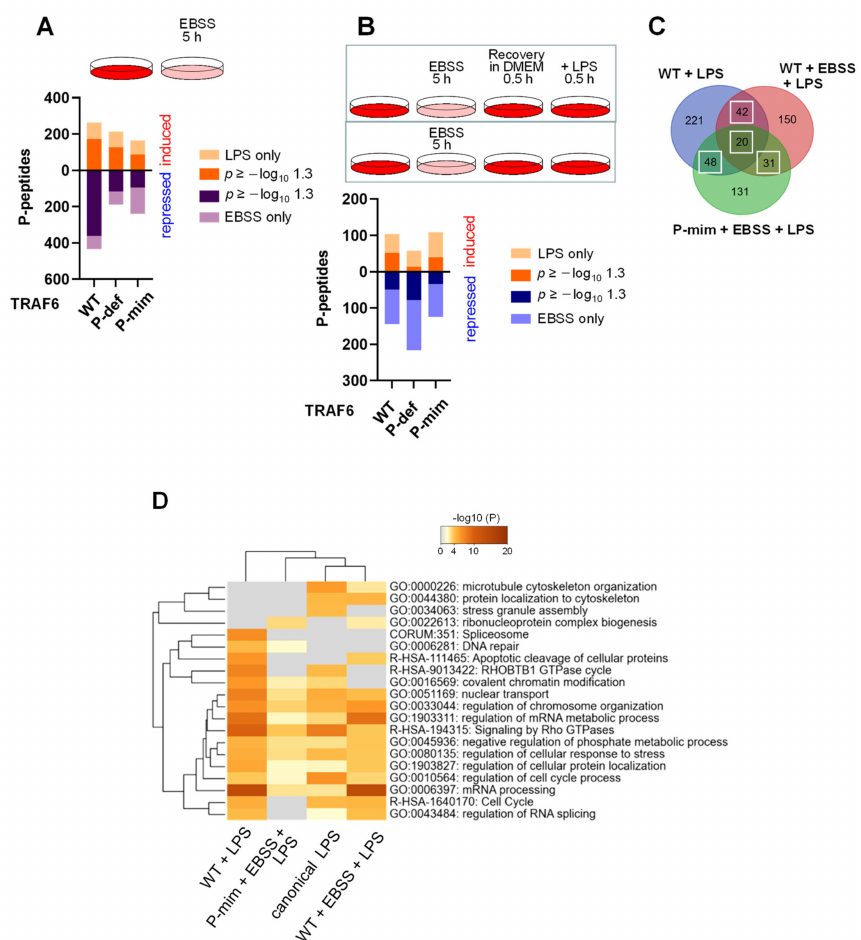
Figure 8. The impact of autophagy and TRAF6 phosphorylation on LPS-triggered phosphorylation networks. ( A ) The top shows the experimental design, the lower part shows the number of phosphopeptides that were increased or decreased after EBSS treatment in the cells expressing TRAF6 and its phospho-mutants. ( B ) Cells were exposed to EBSS, followed by re-addition of complete medium. Then, cells remained untreated (controls) or were stimulated with LPS, as shown, followed by phosphoproteomic analysis. The number of regulated phosphopeptides in the various cell lines is shown. ( C ) Venn diagram comparing the dynamically regulated phosphopeptides from LPS-induced cells in dependence on starvation and TRAF6 phosphorylation as shown. The white boxes mark commonly regulated phosphopetides that are defined as canonical LPS-regulated. ( D ) Protein IDs that map to the canonical group of LPS-regulated phophopeptides as well as to the unique phosphopeptides shown in the Venn of ( C ) were subjected to ORA